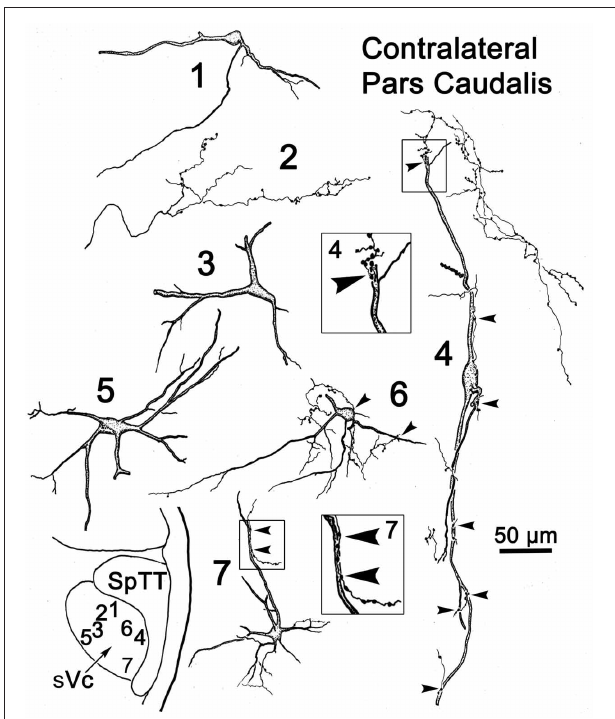
FIGURE 9 | Retrogradely labeled neurons and anterogradely labeled axons in sVc on the contralateral side following the injection into sVc illustrated in Figure 7B. Close associations (arrowheads) between labeled cells (Cells 4 and 7) and axonal boutons are shown in the boxes. The location of the illustrated neurons is shown in the low magnification